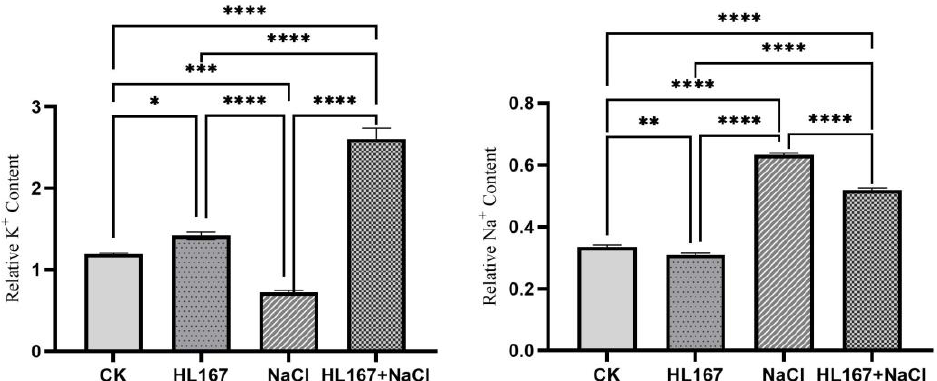
Figure 10. Relative contents of K + and Na + in cowpea. CK represents cowpea seedlings grown under normal conditions; HL167 represents cowpea seeds pretreated with T. longibrachiatum HL167 without salt treatment; NaCl represents cowpea seedlings stressed under 200 mM NaCl; HL167 + NaCl represents cowpea seeds pretreated with T. longibrachiatum HL167 then treated with 200 mM NaCl saline. Small bars represent the standard errors. The asterisk (*) indicates p =0.021, (**) indicates p = 0.0046, (***) indicates p = 0.0002, (****) indicates p < 0.0001.